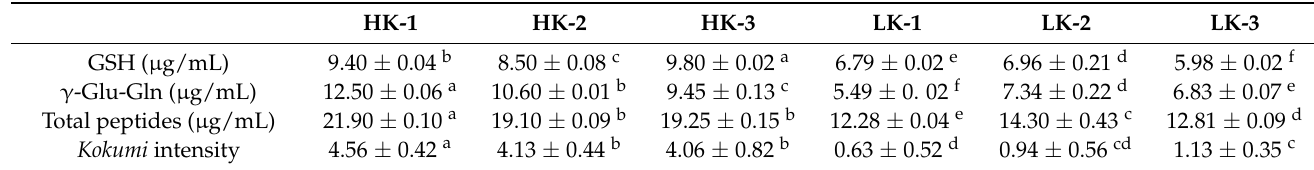
Figure 2. Ultra-high-performance liquid chromatography-tandem mass spectrometry (UHPLC) chromatography of ( A1 ) F-I; ( B1 ) GSH; ( C1 ) F-II; ( D1 ) γ -Glu-Gln; MS fragmentography of ( A2 ) F-I; ( B2 ) GSH; ( C2 ) F-II; ( D2 ) γ -Glu-Gln. Table 2. Kokumi intensity and content of kokumi peptides in different tea